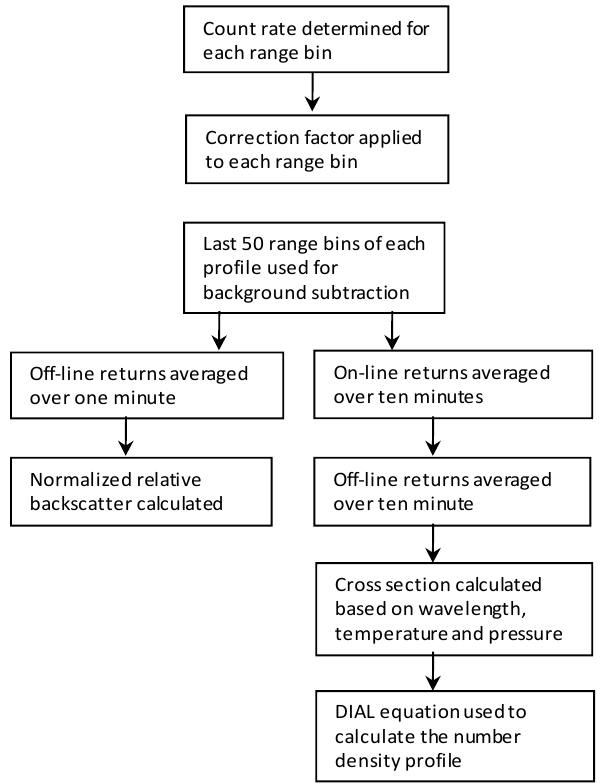
Figure 4. A flow chart summarizing of the data